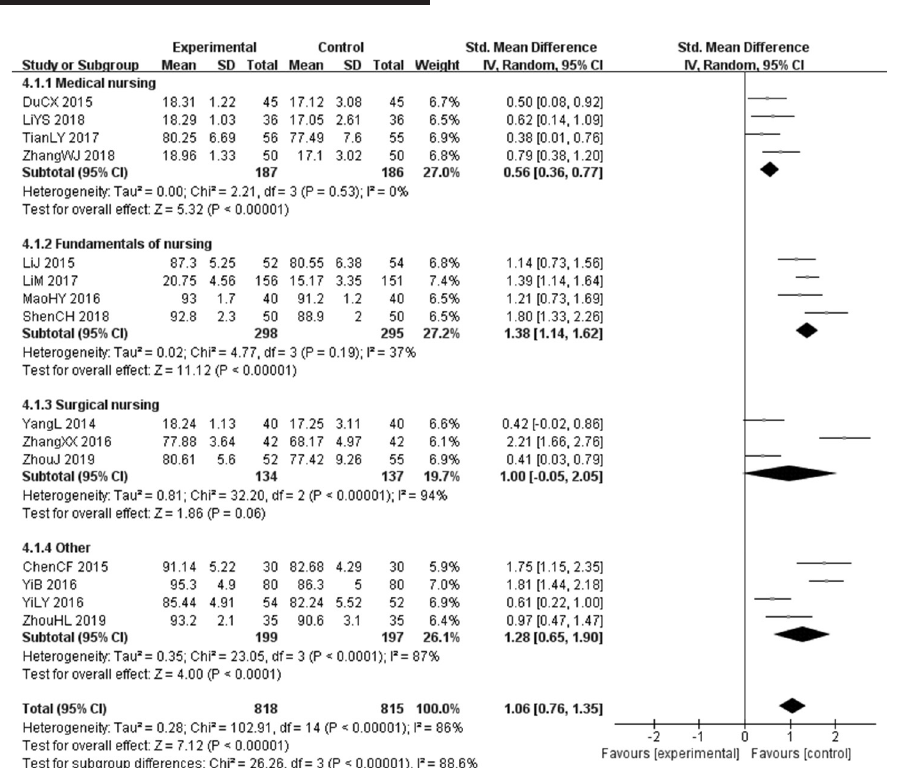
Figure 4. Subgroup analysis of the effect of subjects on nursing students’ operational achievements.